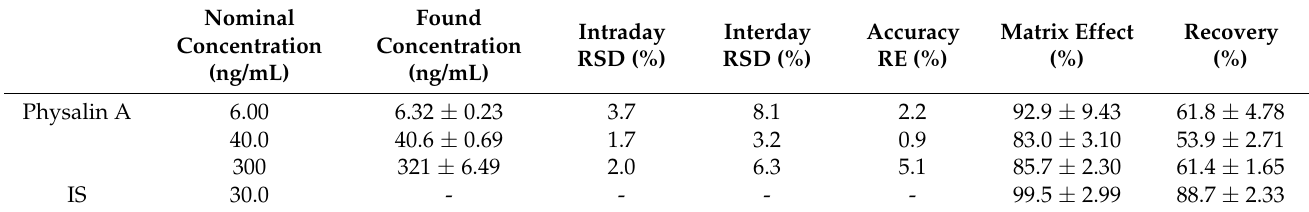
Table 1. Accuracy, precision, extraction recovery and matrix effect for LC–MS/MS analysis of physalin A in rat plasma.